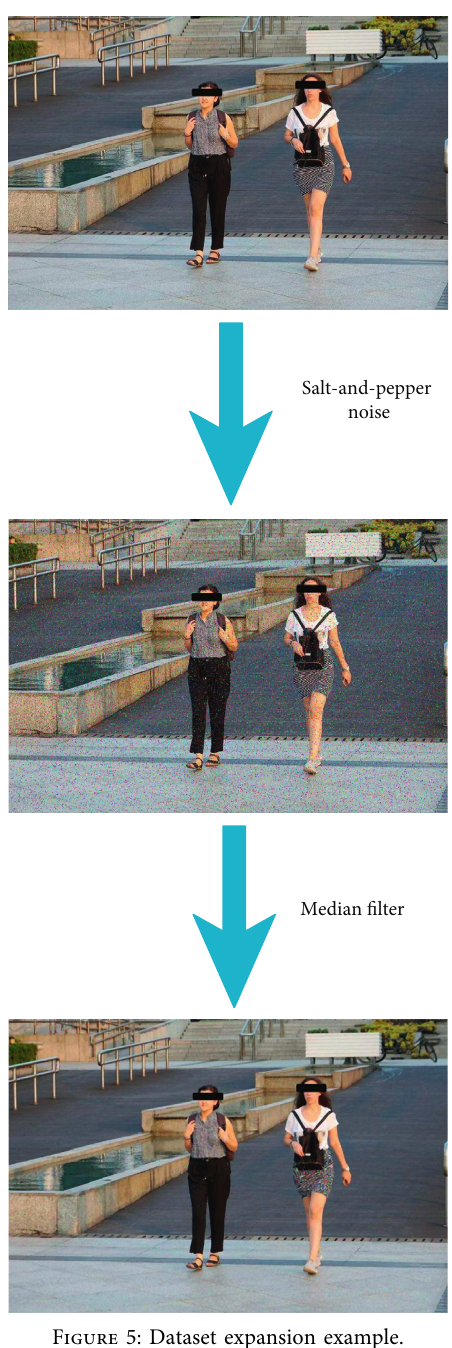
Figure 5: Dataset expansion